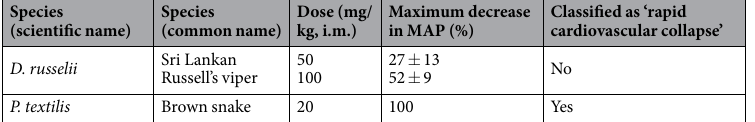
Table 2. Summary of the effects of venom (n = 4) on mean arterial blood pressure following i.m.